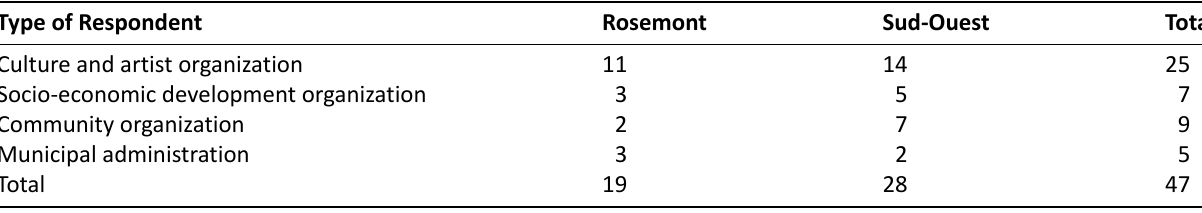
Table 2. Respondents by type and territory. Source: own